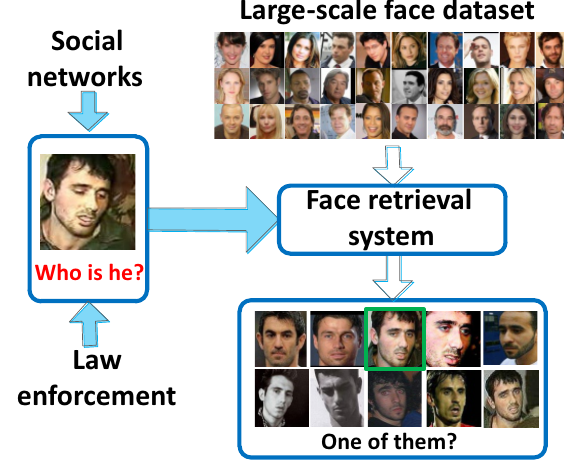
Fig. 1 Example of large-scale face retrieval